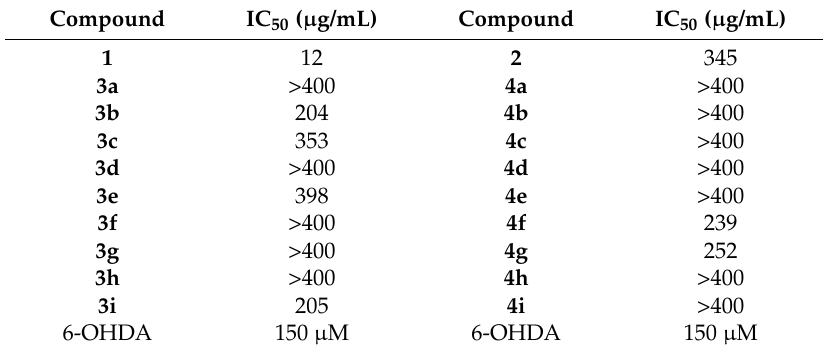
Table 1. IC 50 values of compounds 1 , 2 , 3a – i and 4a – i and 6-OHDA according to the cell viability assay.